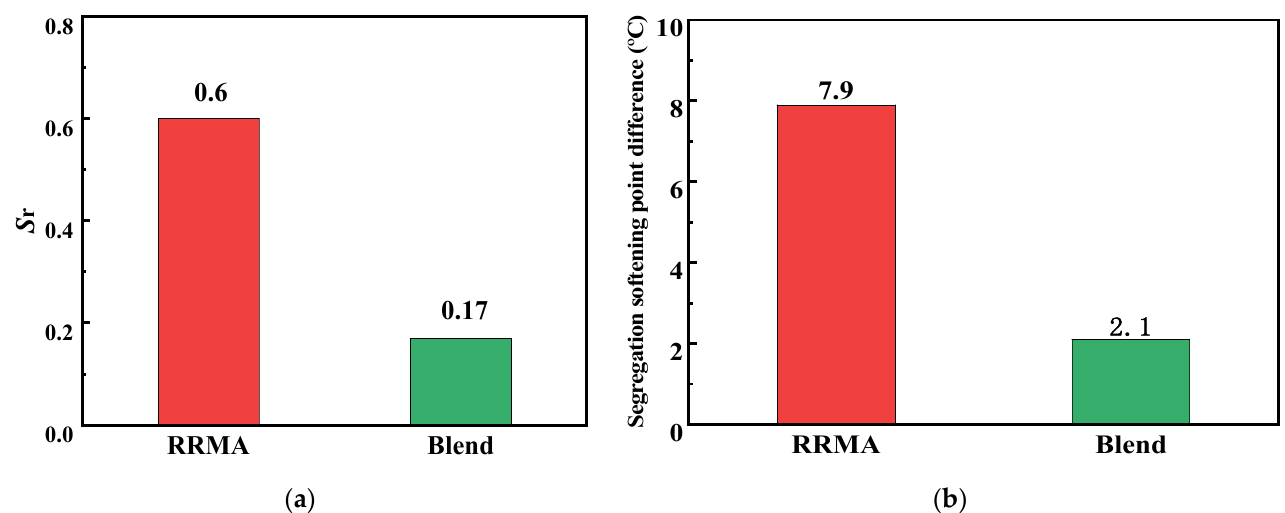
Figure 5. The ( a ) segregation rate (Sr); ( b ) segregation softening point difference of RRMA and Blend. Table 2. DSR test results of RRMA and Blend.